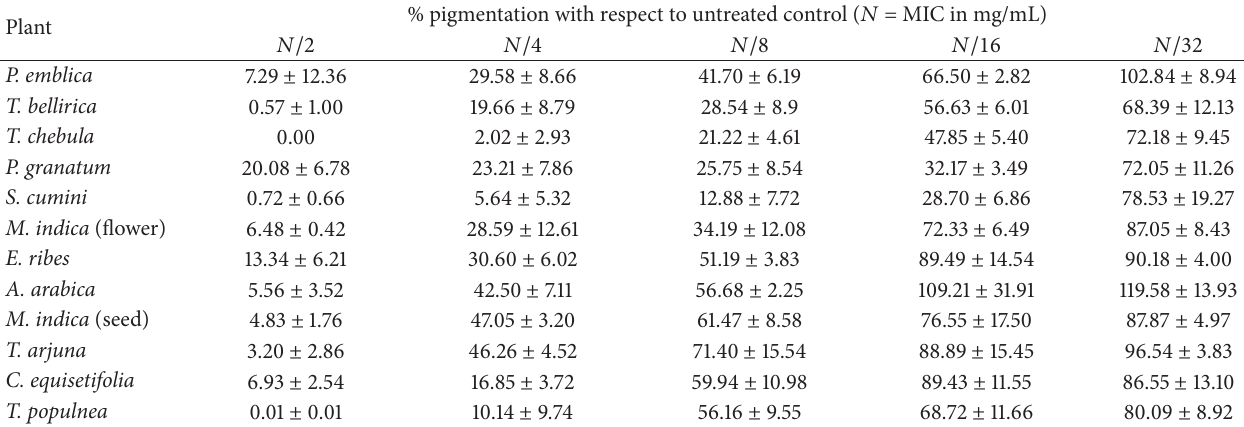
Table 1: Quantitative studies of anti-quorum sensing activity detected as pigmentation in C. violaceum ATCC 12472 in the presence of subinhibitory concentrations of plant extracts.